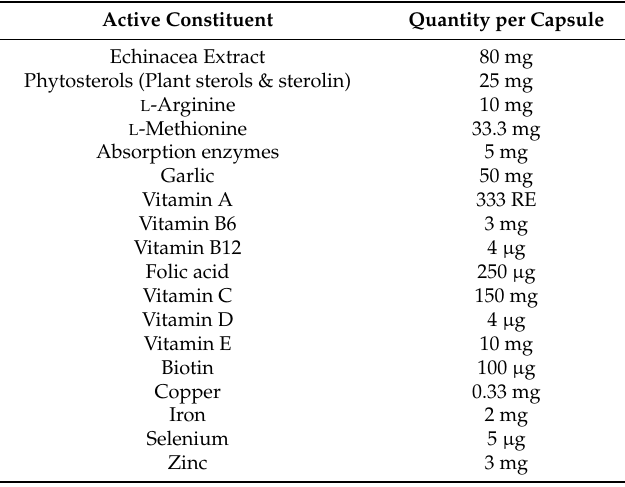
Table 3. Composition of Viral Choice ®